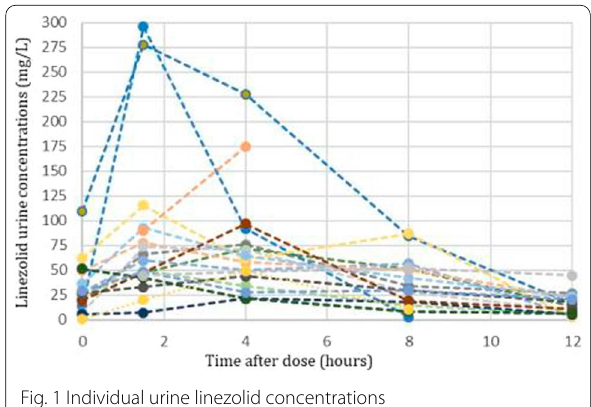
Fig. 1 Individual urine linezolid